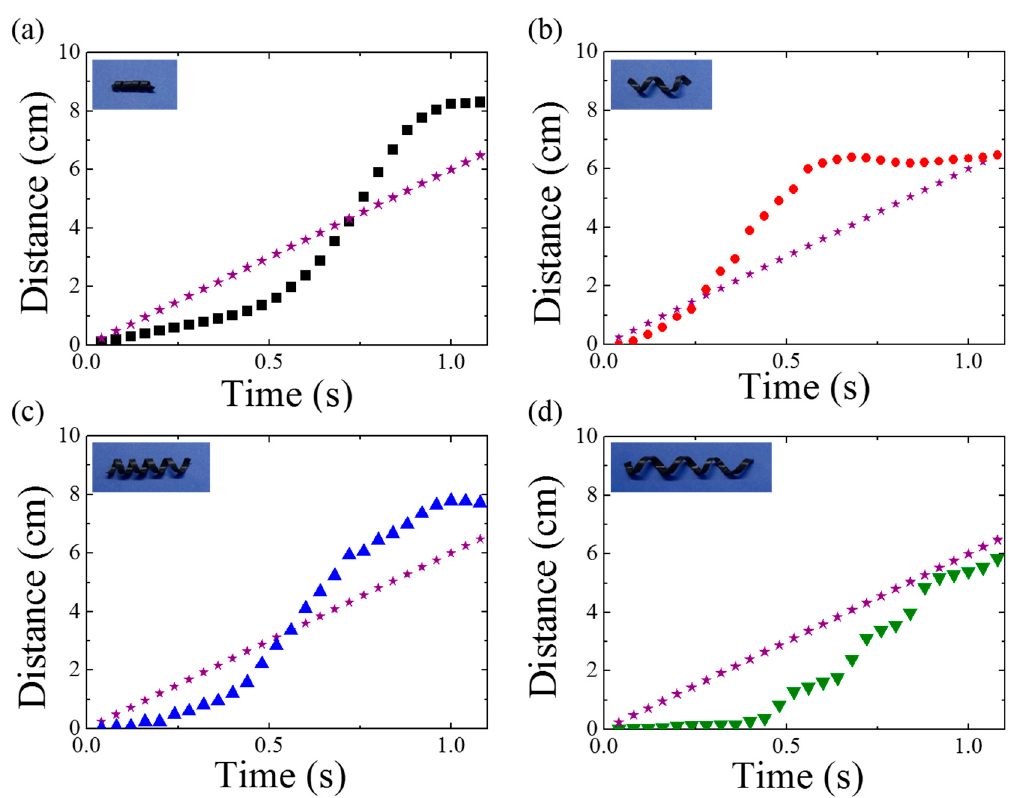
Figure 2. Time-resolved distance information obtained using magnetomotility for helical soft robots of (a) D2-L15, ( b ) D5-L20, ( c ) D5-L25, and ( d ) D5-L35 rolled on a flat surface. The asterisk indicates the travel distance of the magnet underneath the substrate.